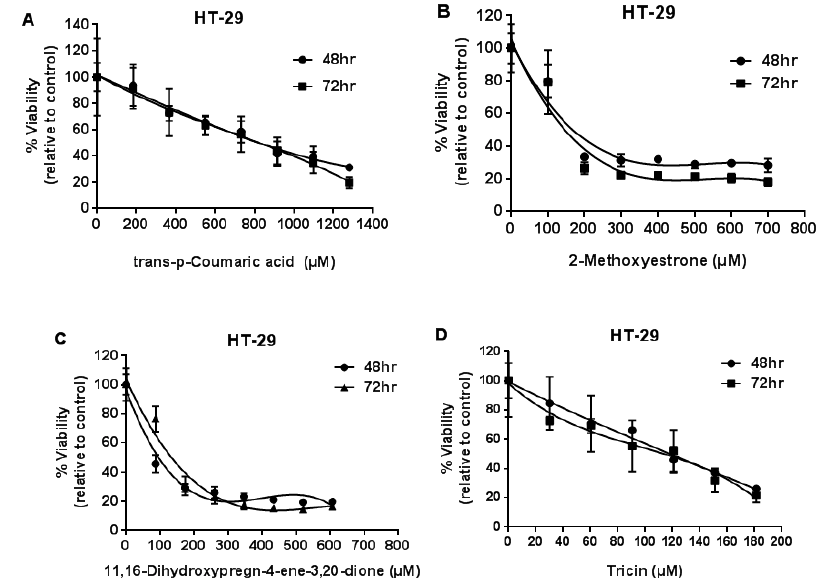
Figure 9. The growth inhibitory effects of compounds ( 1 )–( 4 ) on HT-29 (colon cancer cell line) were evaluated after 48/72 h treatment by MTT assay.